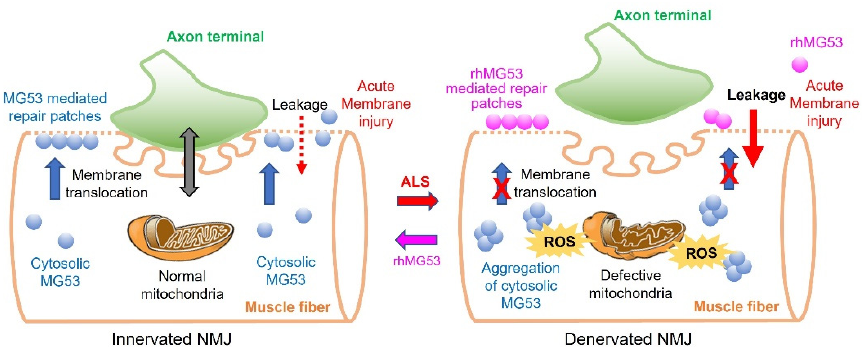
Figure 1. Proposed mechanisms of membrane repair defects at NMJ in ALS and the restoration by exogenous rhMG53. NMJ is the critical site of neuromuscular interactions. During ALS progression, abnormalities in mitochondrial respiratory activities at NMJ elevates ROS production, leading to ectopic aggregation of cytosolic MG53, undermining its membrane repair function, which exacerbates sarcolemma disruption leading to accumulation of extracellular content in the cytosol. Exogenously applied rhMG53 could be recruited to the sites of membrane injury, forming sealing patches to alleviate the cell membrane